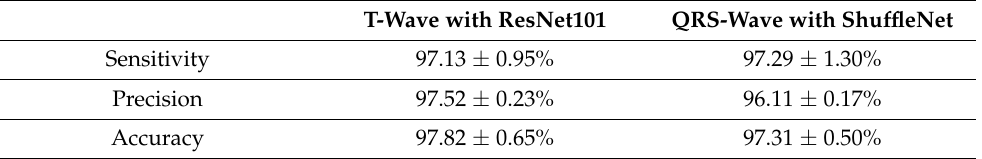
Table 6. Results of 5 K-fold using two